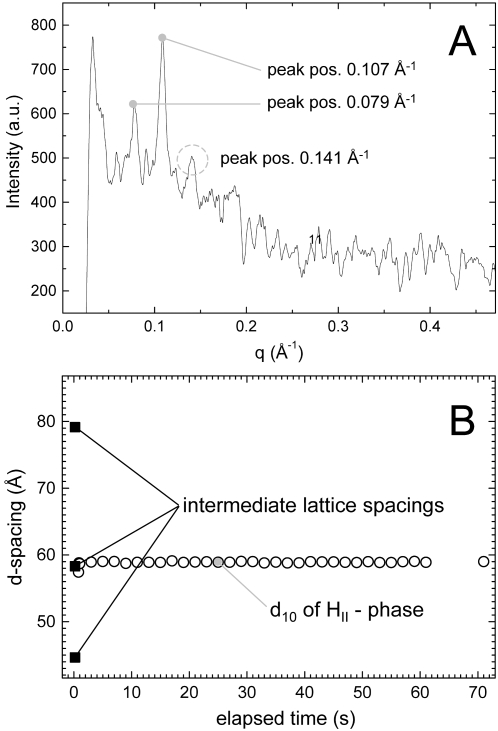
Intermediate formation referring to the rapid-mixing experiment of Figure 7.(A) The SAXS pattern is averaged from the data taken in the range of 100–400 ms after the rapid mixing. It indicates a possible formation of bicontinuous cubic phase of the symmetry Pn3m. The observed Bragg peaks and their presented q-values, suggest a coexistence with the H2 phase (for details see text). (B) Temporal evolution of the observed lattice spacings.